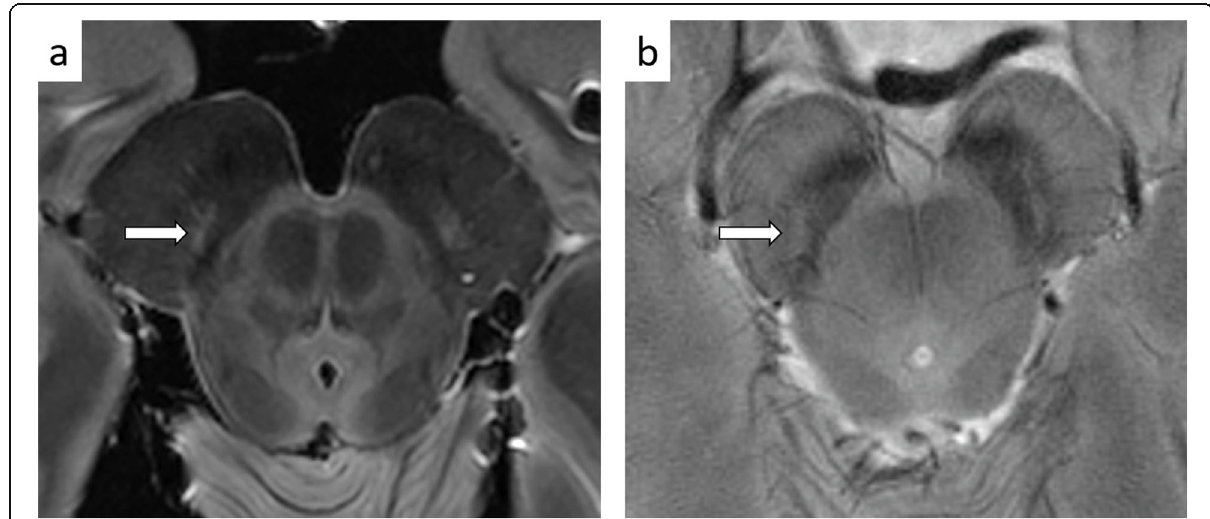
Fig. 2 Ex vivo and in vivo MR imaging of the SN. The oval-shaped hyperintense formation indicated by arrows corresponds to nigrosome 1 (N1). a Proton density axial image of an ex-vivo sample. b Gradient echo imaging at high resolution allows to define the N1 formation with typical “ swallow tail appearance ” in healthy subjects in